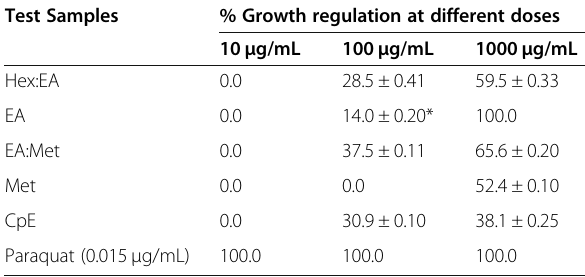
Table 1 Phytotoxic effect of Spondias mombin stem bark and Paraquat at various concentrations against fronds of Lemna minor